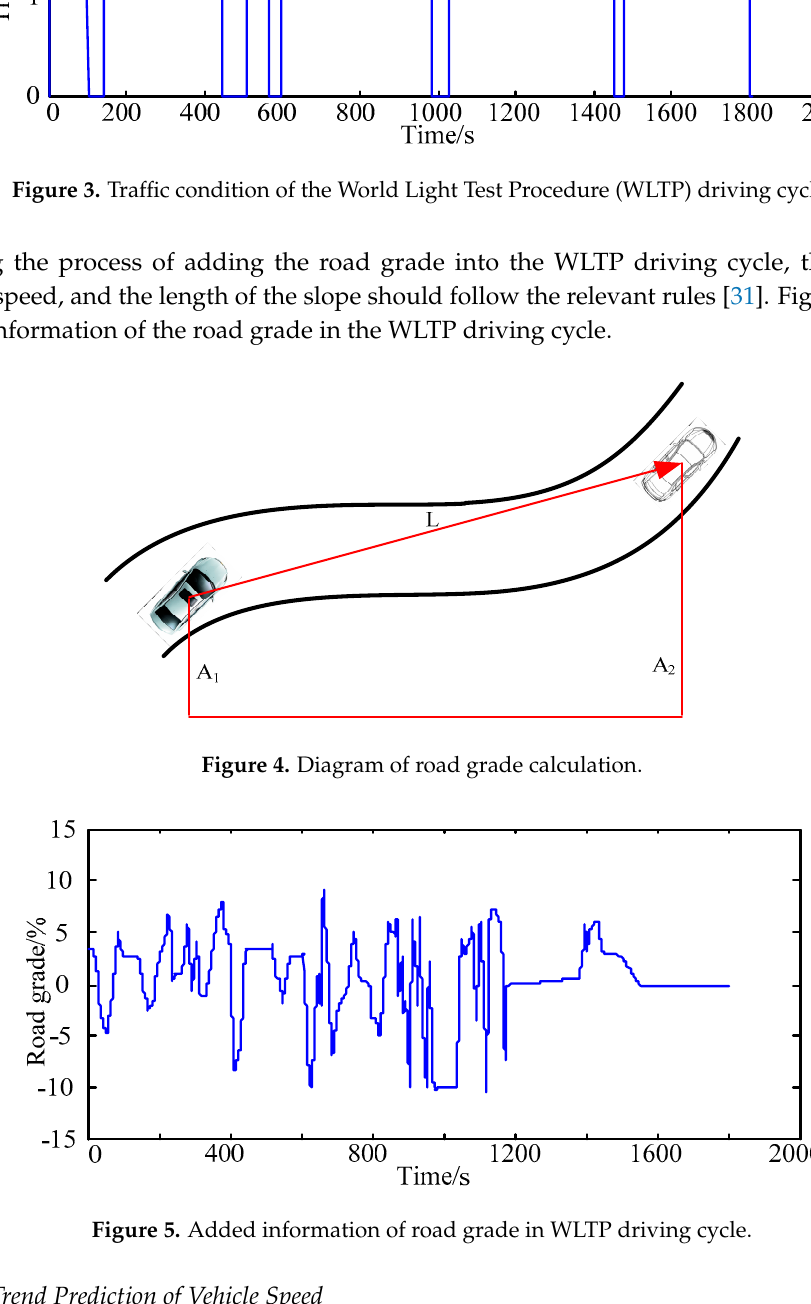
Figure 3. Traffic condition of the World Light Test Procedure (WLTP) driving cycle.